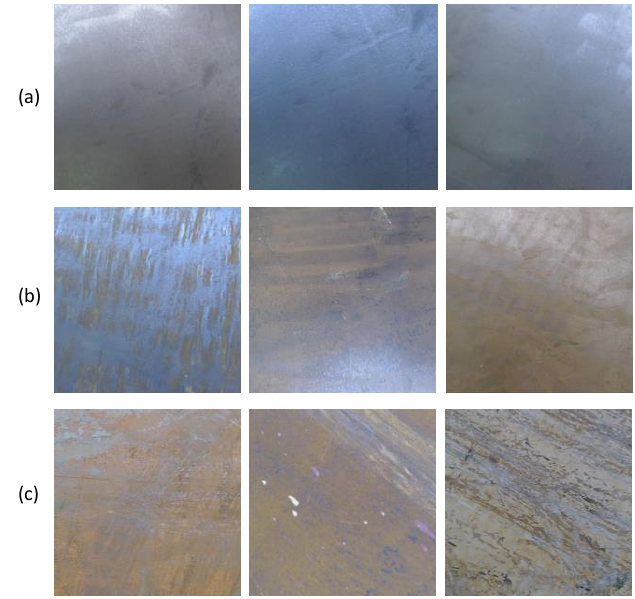
Figure 2. Categorization of the blasting quality considered for benchmarking. ( a ) Appearances of good areas; ( b ) Appearances of medium quality areas; ( c ) Appearances of bad quality